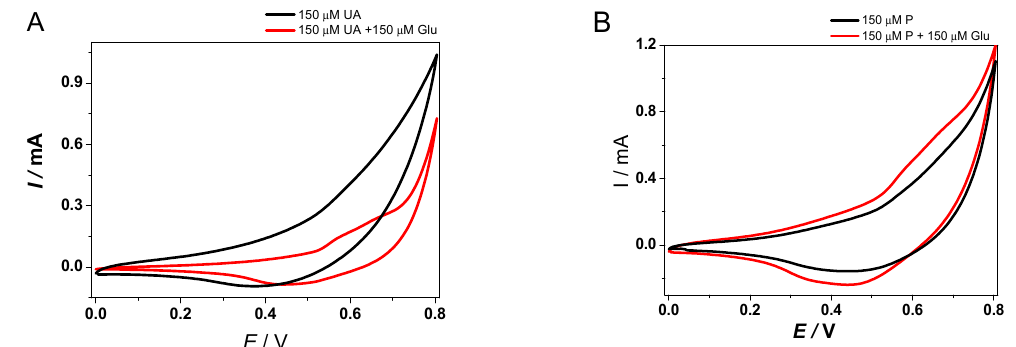
Figure 9. CV in 0.1 M NaOH solution in the presence of 150 µ M UA ( A ) and 150 µ M P ( B ) as interfering agents in the absence (black line) / presence (red line) of 150 µ M Glu. (0–0.8 V, scan rate 25mV / s, working electrode surface area of 25 mm 2 ).